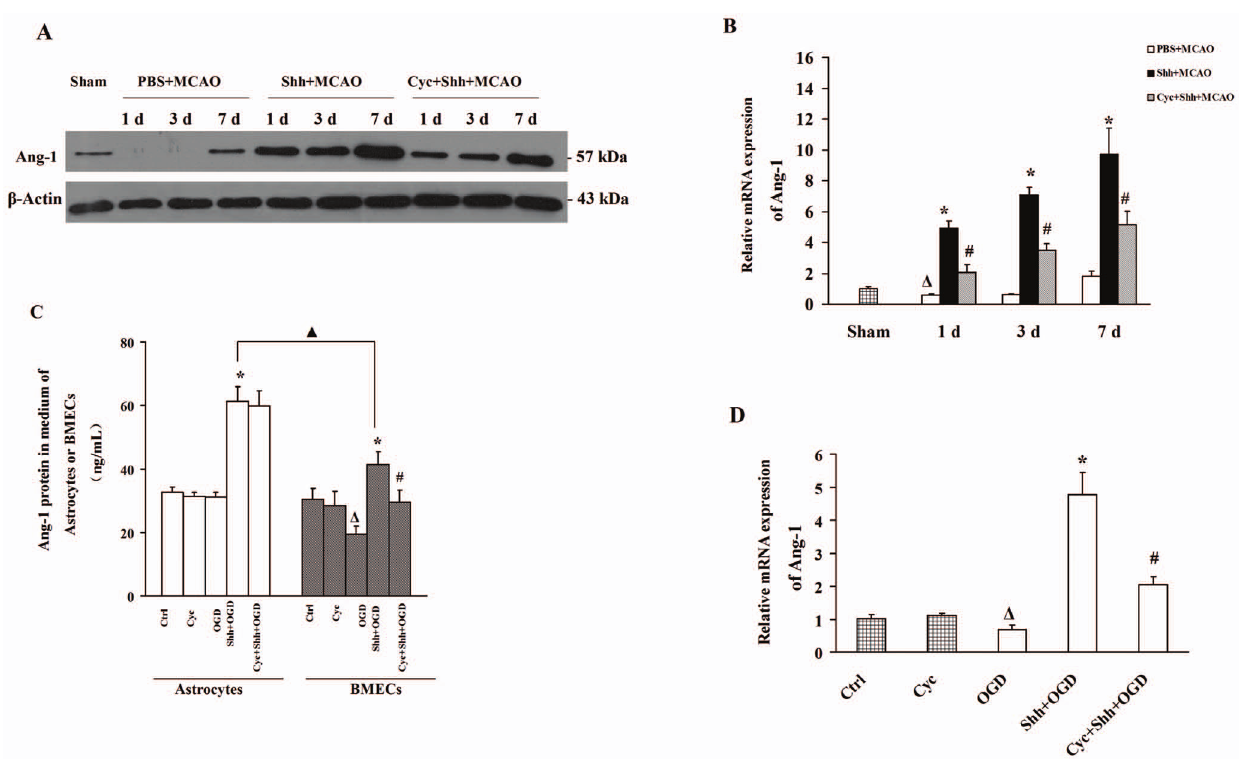
Figure 5. Shh Treatment Upregulates the Expression of Ang-1 Under Ischemic Condition invivo and invitro . (A–B) After establishment of pMCAO, rats were intracerebroventricularly injected 3 m L of PBS, 3 m g of Shh, and Shh (3 m g) plus cyclopamine (Cyc, 30 m g). The expression of Ang-1 was detected by Western blotting and real-time RT-PCR at indicated time points (1 d, 3 d, and 7 d). (A) Representative photographs of Western Blotting bands. (B) The mRNA levels of Ang-1. Grouping was the same as above. (C) BMECs or astrocytes were pre-treated with PBS, Shh and/or Cyc for 30 min, and then subjected to the OGD for 4 h. The concentration of Ang-1 protein in the supernatal of cells in different groups was determined by ELISA. (D) BMECs were pre-treated with PBS, Shh and/or Cyc for 30 min, and then subjected to the OGD for 4 h. The mRNA levels of Ang-1 were determined by real-time RT-PCR. Grouping was the same as above. D P , 0.01 vs. the Ctrl group, * P , 0.01 vs. the OGD group, # P , 0.01 vs. the Shh group. m P , 0.01 vs. the BMECs group. Each experiment was repeated three times (n=6, each group).